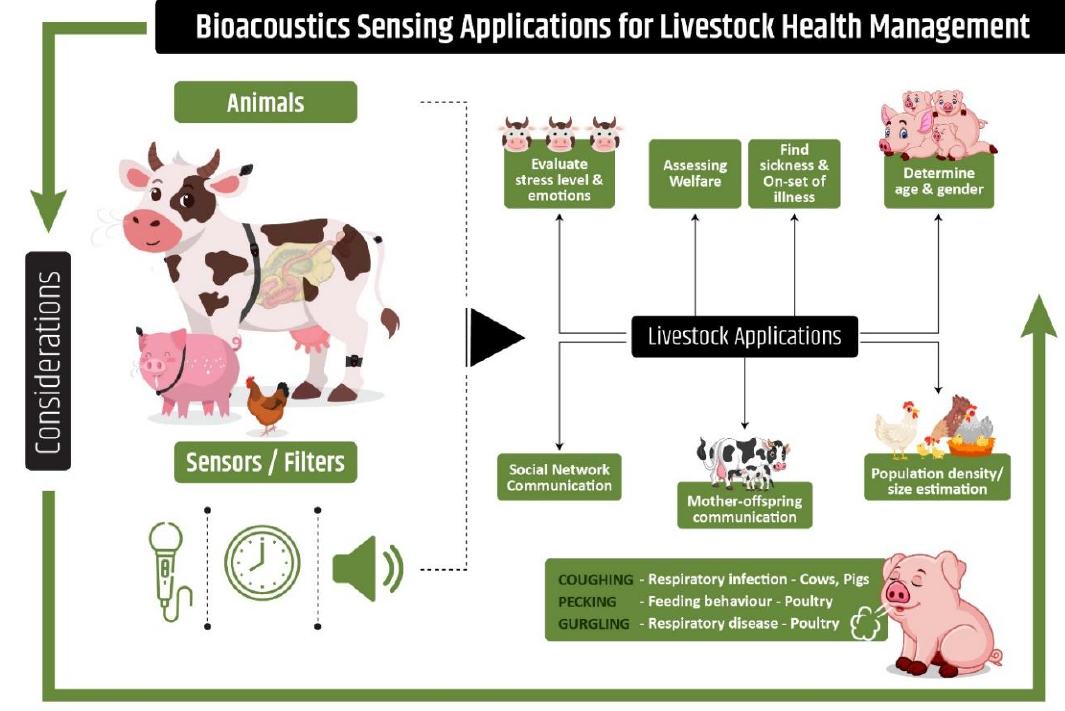
Figure 2. Bioacoustics applications in Precision Livestock Farming. Physiological parameters measurement through on-line sound analysis as a basis for health and welfare monitoring in pigs, cows, and poultry.